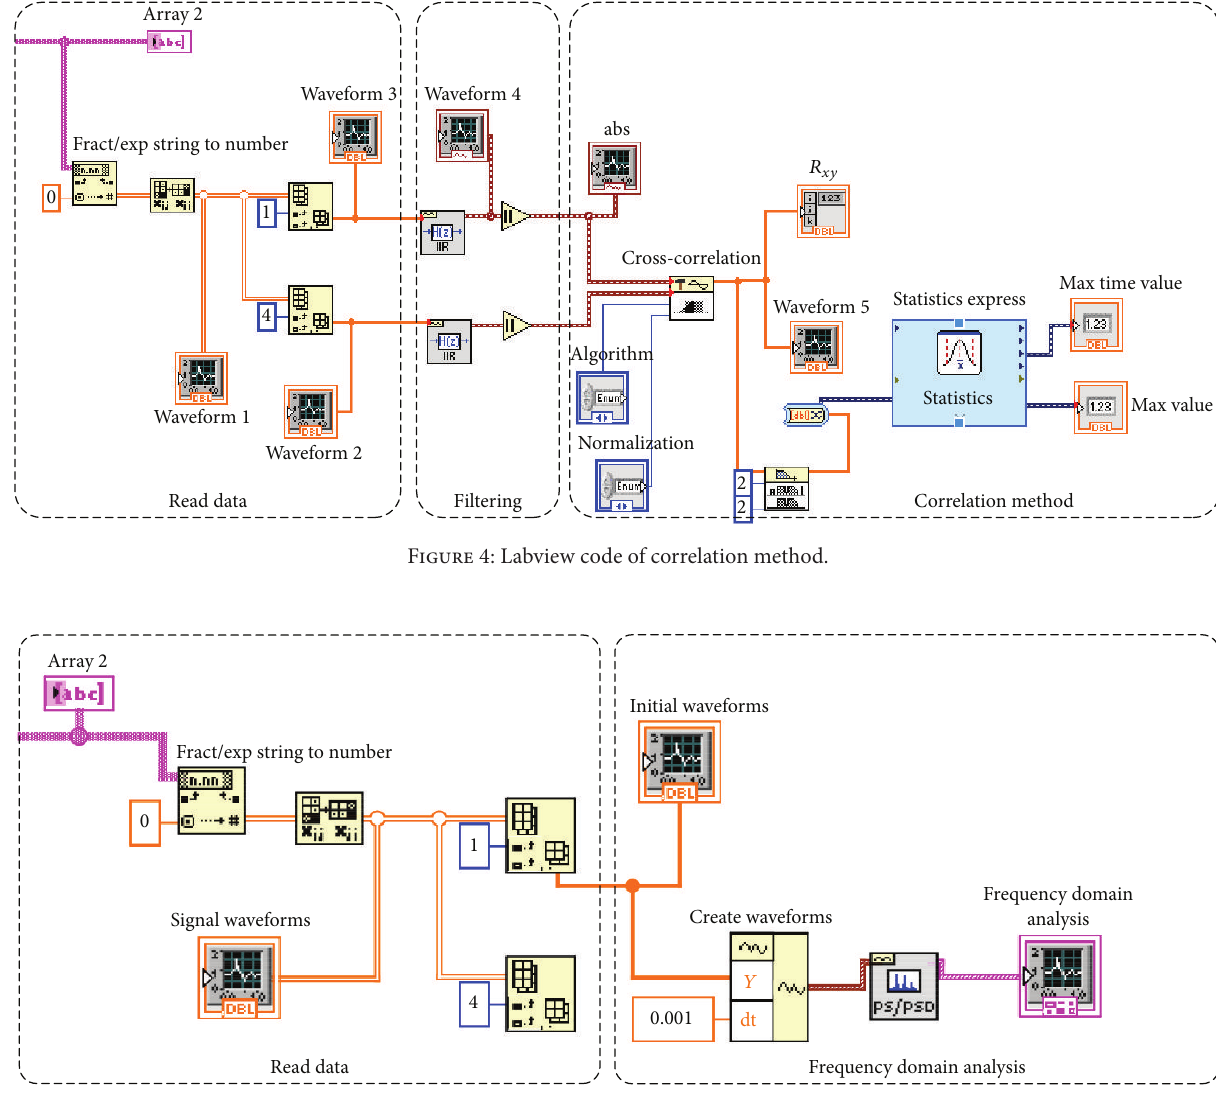
Figure 5: Labview code of spectrum